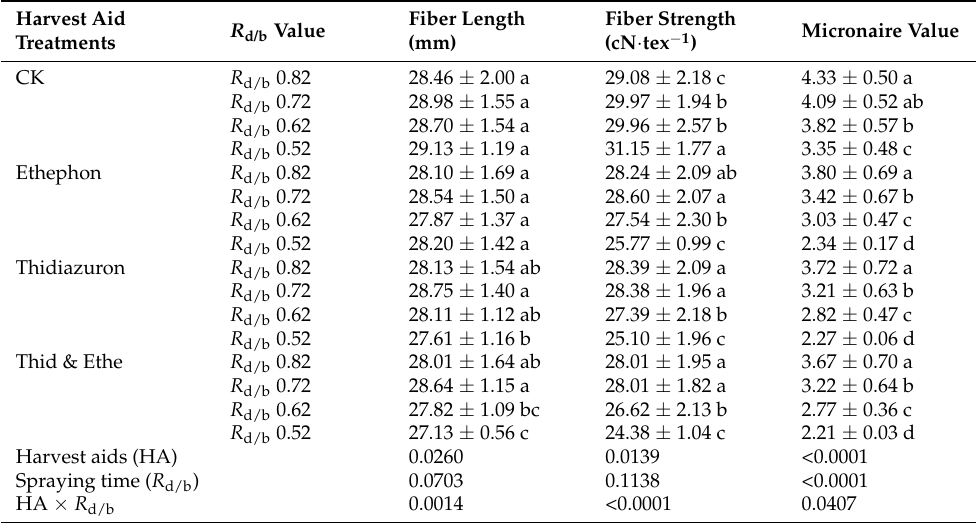
The values are expressed as means ± SD. Different letters in the same column indicate significant differences